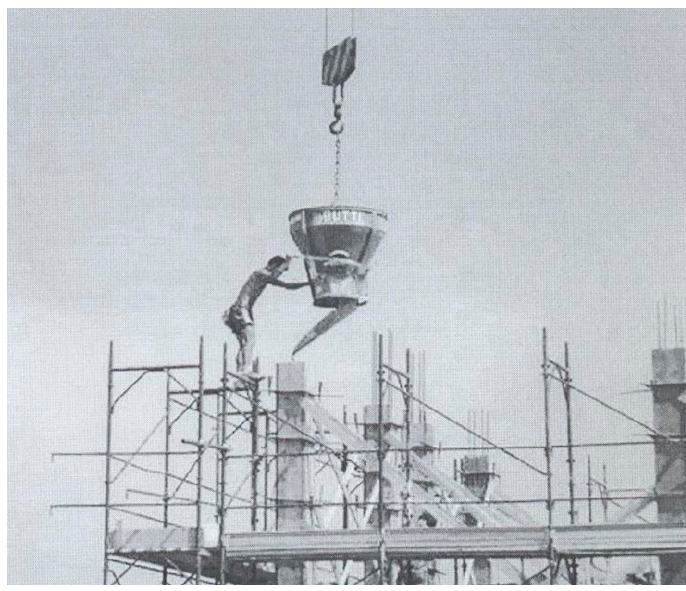
Figure 2. The old conventional concrete construction